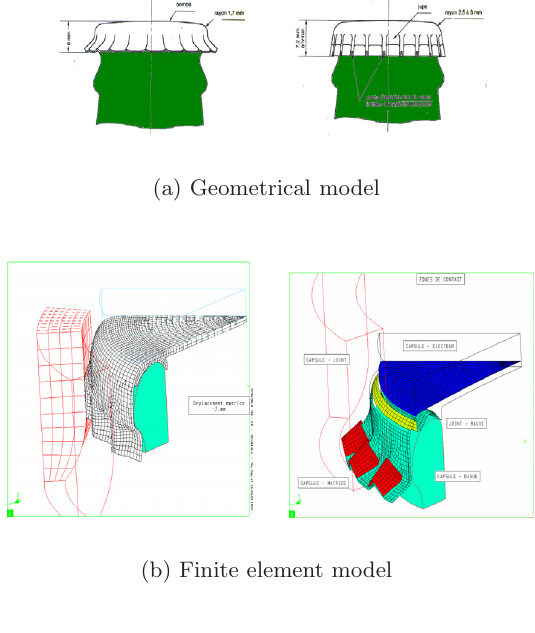
Fig. 1. Metal bottle